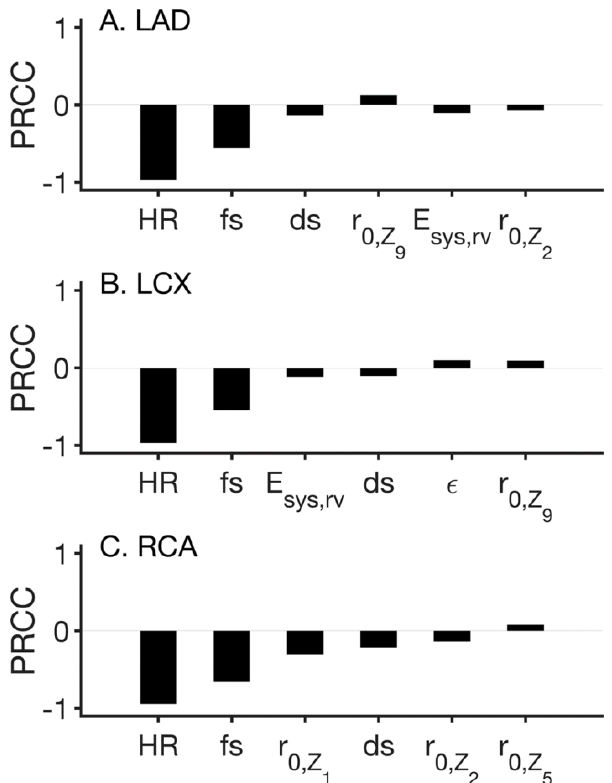
Figure 7. PRCC sensitivity of FFR to model control parameters. In all panels, the sensitivity of FFR to the six most relevant parameters are shown. Panel ( A ) shows the PRCC for LAD, panel ( B ) for the LCX, and panel ( C ) for the RCA. In all panels, HR: heart rate; fs: focal stenosis; ds: diffuse stenosis; r 0 : root radius of microvascular bed; Z i : microvascular impedance; : microvasculature taper exponent; and E sys, rv : systolic elastance of the right ventricle.